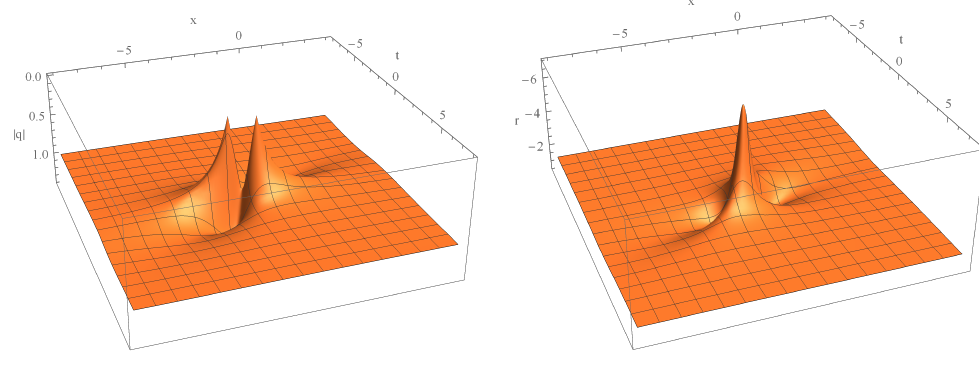
Figure 6. A rogue-wave